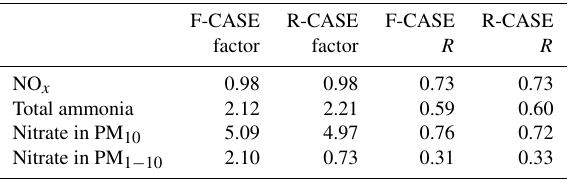
Table 2. Comparison of WRF-Chem results with Melpitz near- ground filter measurements. The factors (simulation/measurement) and correlation coefficient ( R ) are shown for the F-CASE and the R-CASE, respectively.